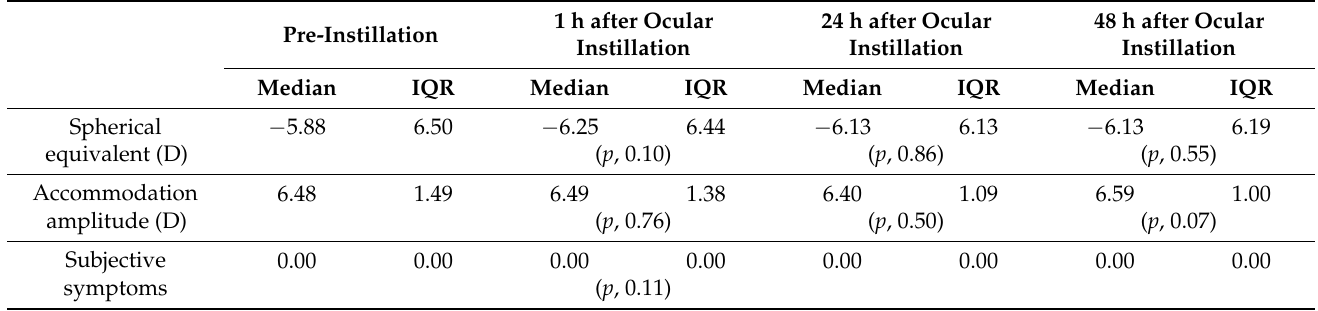
Table 2. Change in refraction, accommodation amplitude, and subjective symptoms after the instillation of 0.01% atropine eye